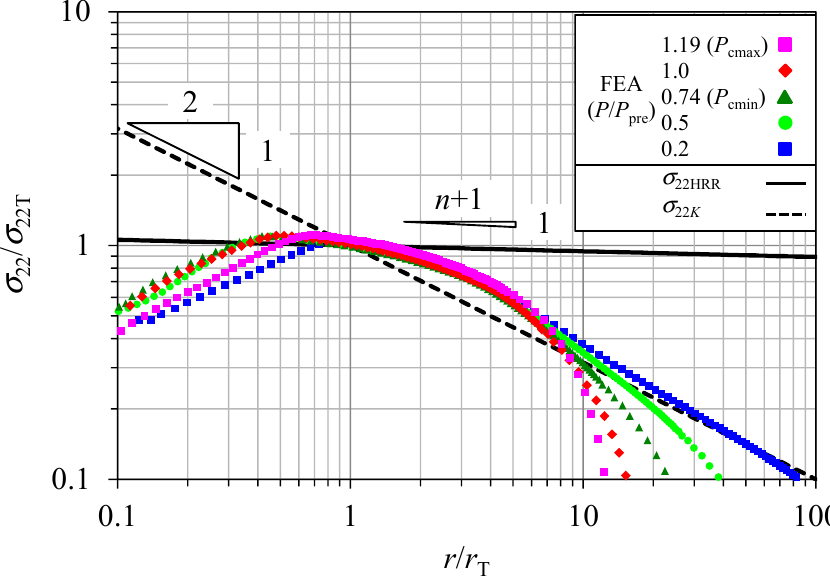
Figure 5. Crack-tip stress distribution without CRS for P / P pre = 0.2, 0.5, 1.0, and 1.19. A significant difference was not observed in the maximum value of the σ 22 distribution for each load level; i.e., the maximum value of σ 22 reached the HRR stress from a low load level. Here, P pre is the preload used for the case with CRS.